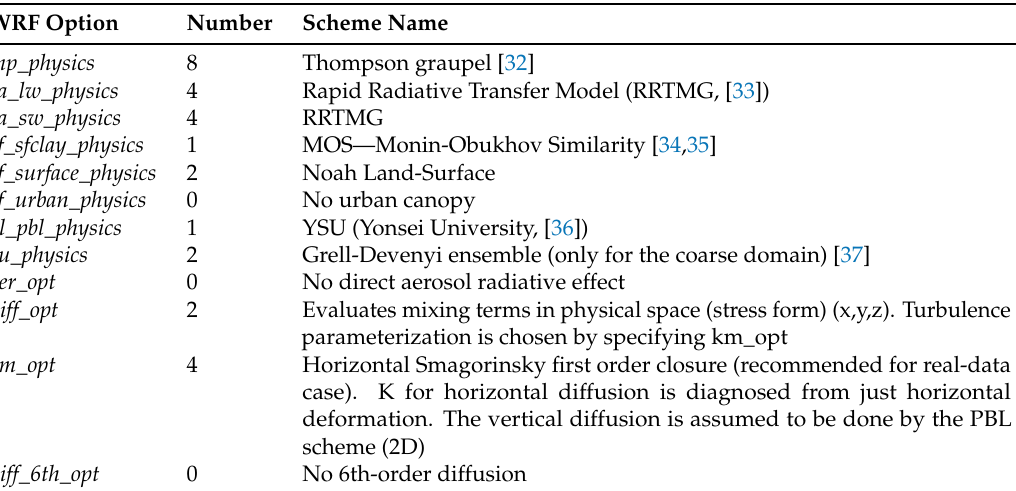
Table 1. Main WRF options for the reference simulation